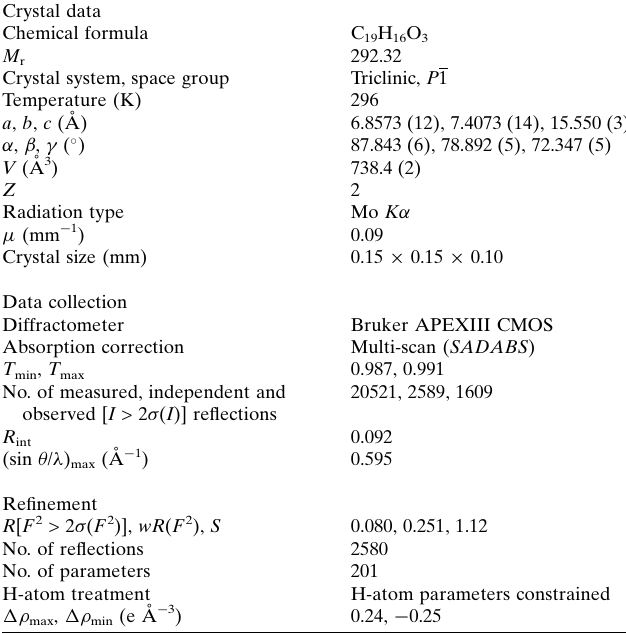
Table 2 Experimental details. Figure 1